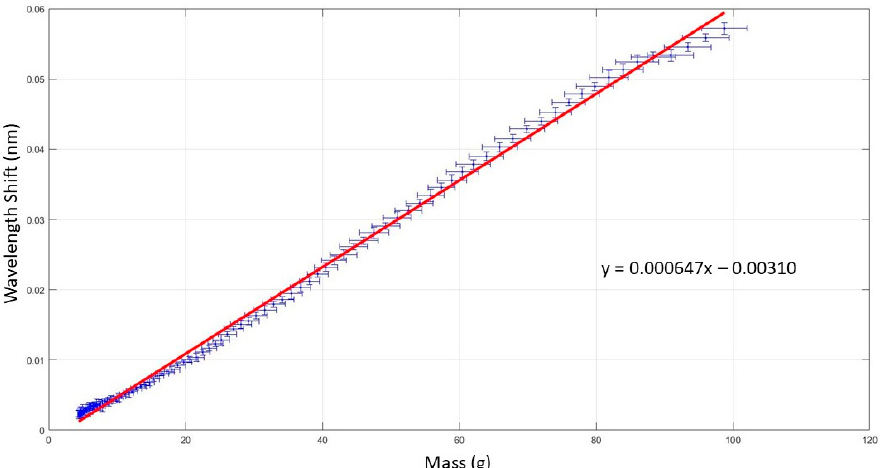
Figure 7. Typical calibration results of the FOPS: wavelength shift against load weight using experi- mental set up illustrated in Figure 2.